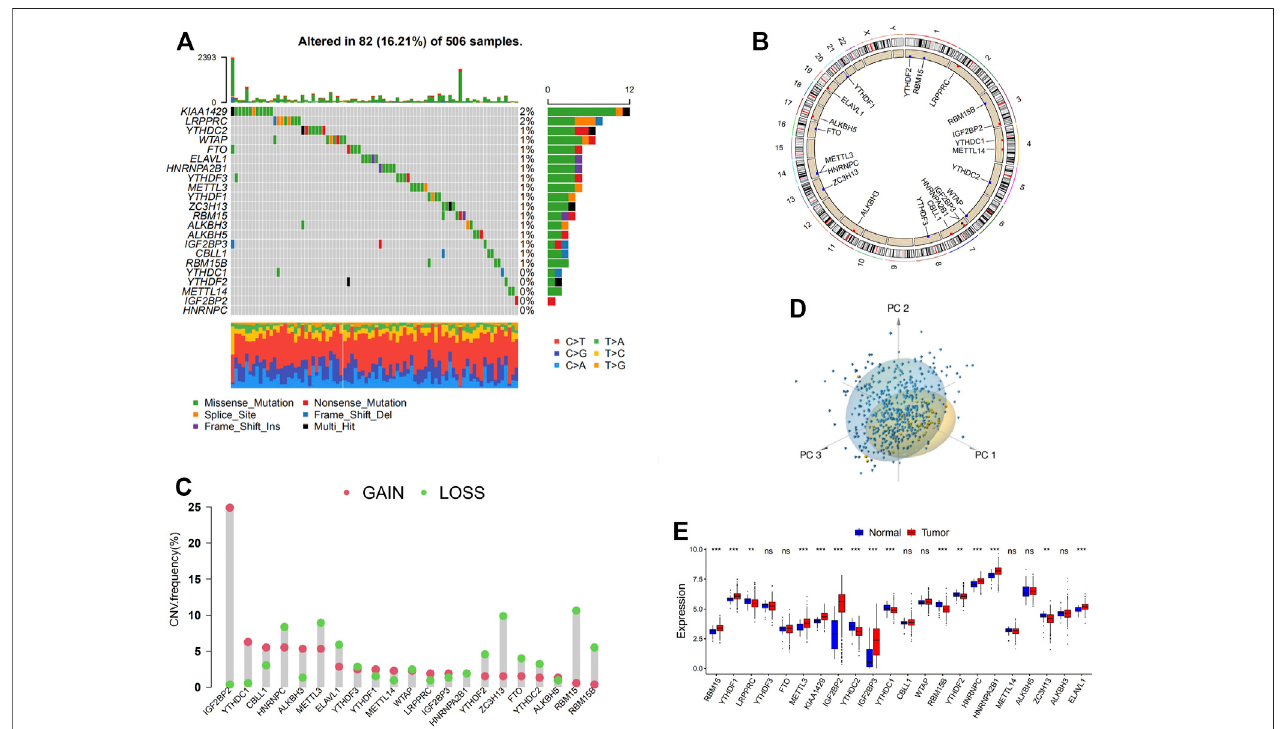
FIGURE 1 | Landscape of genetic and expression variation of m6A regulators in head and neck cancer. (A) The mutation frequency of 21 m6A regulators in 506 patients with head and neck cancer. Each column represents individual patients. The upper barplot shows tumor mutational burden (TMB). The number on the right indicates the mutation frequency in each regulator. The right barplot shows the proportion of each variant type. The stacked barplot below shows a fraction of conversions in each sample. (B) The copy number variation (CNV) frequency of m6A regulators in GSE41613 cohort. The height of the column represents the alteration frequency. The deletion frequency, blue dot; the ampli fi cation frequency, red dot. (C) The location of CNV alteration of m6A regulators on 23 chromosomes using GSE41613 cohort. (D) Principal component analysis for the expression pro fi les of 21 m6A regulators to distinguish tumors from normal samples in GSE41613 cohort. Two subgroups without intersection were identi fi ed, indicating the tumors and normal samples were well distinguished based on the expression pro fi les of m6A regulators. Tumors are marked in blue, and normal samples are marked in yellow. (E) The expression of 21 m6A regulators between normal tissues and cancer tissues. Tumor, red; normal, blue. The upper and lower ends of the boxes represent the interquartile range of values. The lines in the boxes represent median value, and black dots show outliers. The asterisks represent the statistical p -value (* p < 0.05; ** p < 0.01; *** p < 0.001).